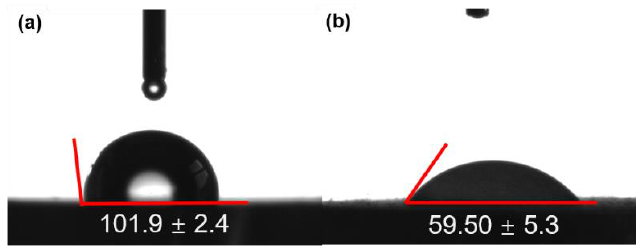
Figure 8. Wetting angles of water on ( a ) pure Zn and ( b ) MAO1 − HT